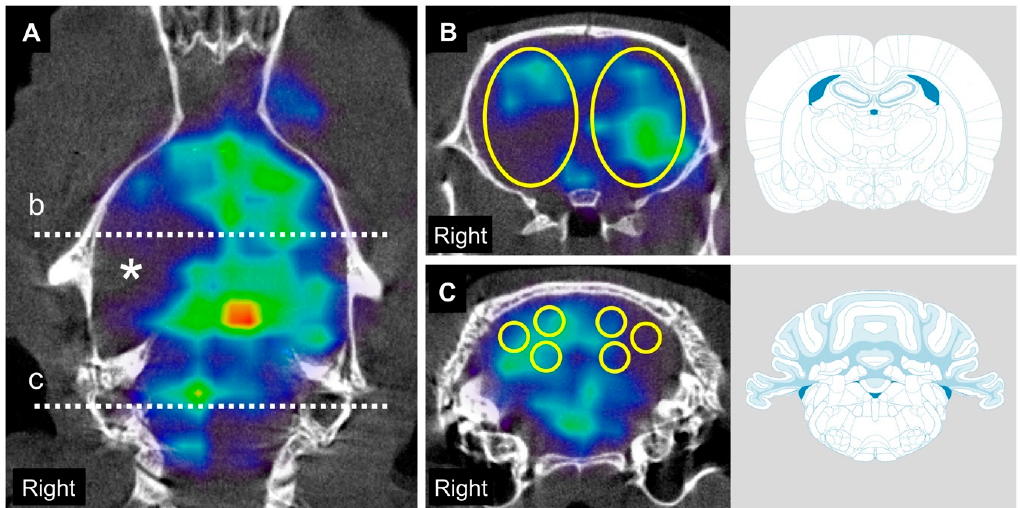
Figure 1. Single photon emission computed tomography (SPECT) / computed tomography (CT) images and regions of interest (ROI) settings to evaluate cerebral and cerebellar blood flow after MCAO. SPECT acquisitions were color-coded with National Institute of Health spectrum color scale. ( A ), Vertical section of SPECT/CT image obtained 2 days after middle cerebral artery occlusion (MCAO) shows obvious hypointensity at the right middle cerebral artery territory (*). Dashed line “b” indicates the coronal slice 2 mm posterior from bregma and dashed line “c” indicates the coronal slice 11 mm posterior from bregma. ( B ) In the coronal slice 2 mm posterior from bregma, 6 × 9 × 6 mm 3D-elliptical ROIs were symmetrically placed. ( C ) In the coronal slice 11 mm posterior from bregma, 2 × 2 × 2 mm global ROIs were symmetrically placed at medial cerebellar cortex, lateral cerebellar cortex and cerebellar nuclei of each side respectively.